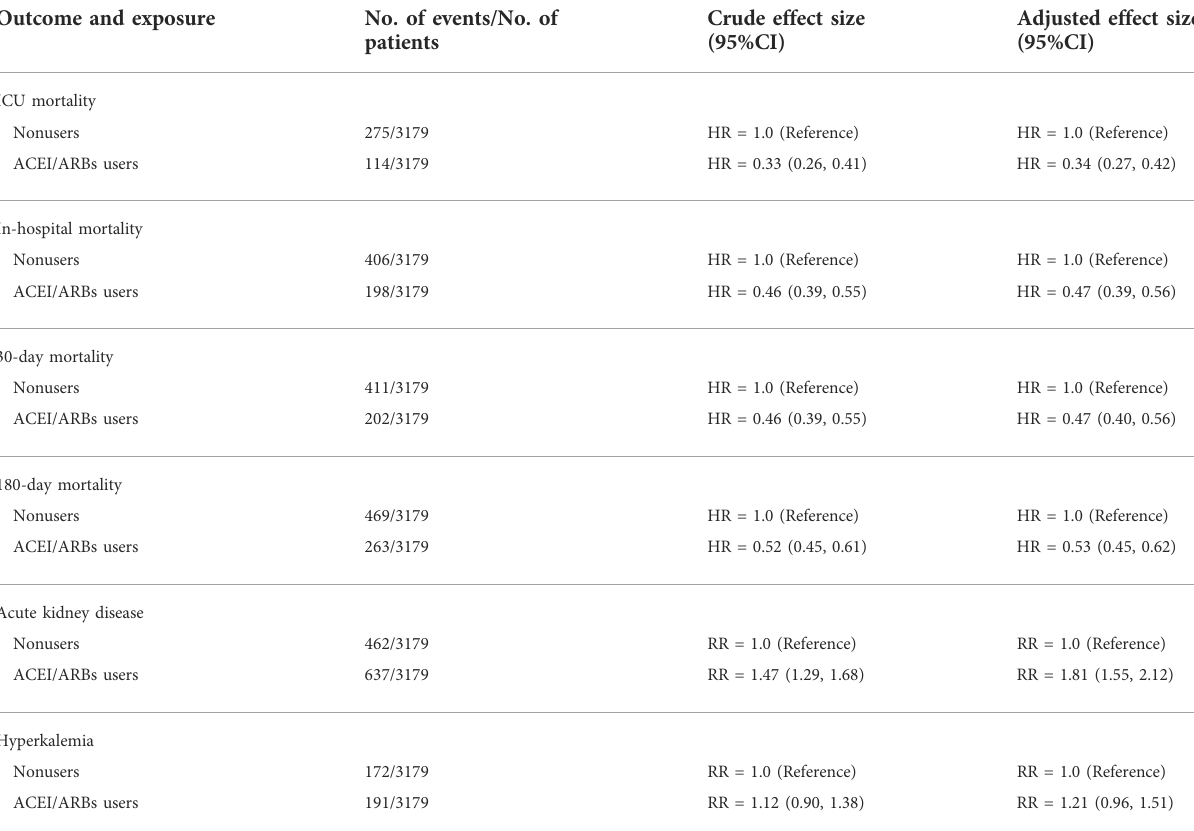
TABLE 2 Survival and composite outcomes associated with ACEI/ARB use in propensity score – matched patients with AKI. Outcome and